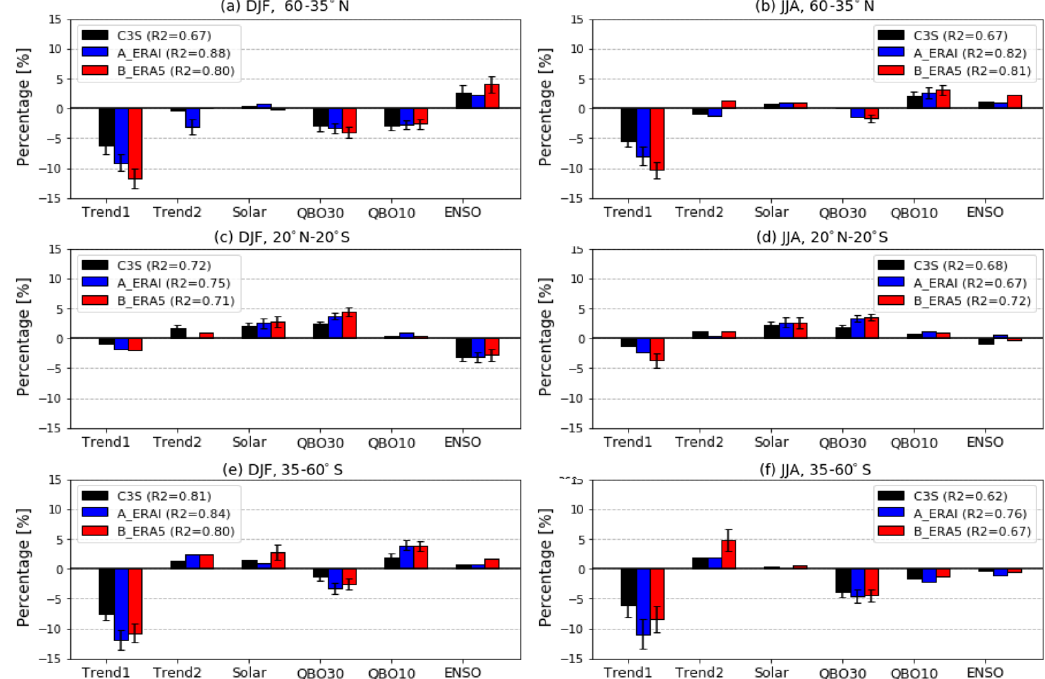
Figure 4. Peak contributions (in %) from piecewise linear trend and explanatory variable terms (see Eq. 1) to the total ozone column variability during DJF and JJA for (a, b) 60–35 ◦ N, (c, d) 20 ◦ N–20 ◦ S, and (e, f) 35–60 ◦ S for C3S, A_ERAI, and B_ERA5 during 1979– 2018. Error bars indicate the confidence bounds at the 95% statistical significance level quantified by ± 2 standard deviations ( σ ). The determination coefficients ( R 2 ) of the regression model for DJF and JJA mean TCO time series from C3S, A_ERAI, and B_ERA5 over the 60–35 ◦ N, 20 ◦ N–20 ◦ S, and 35–60 ◦ S regions are presented in each